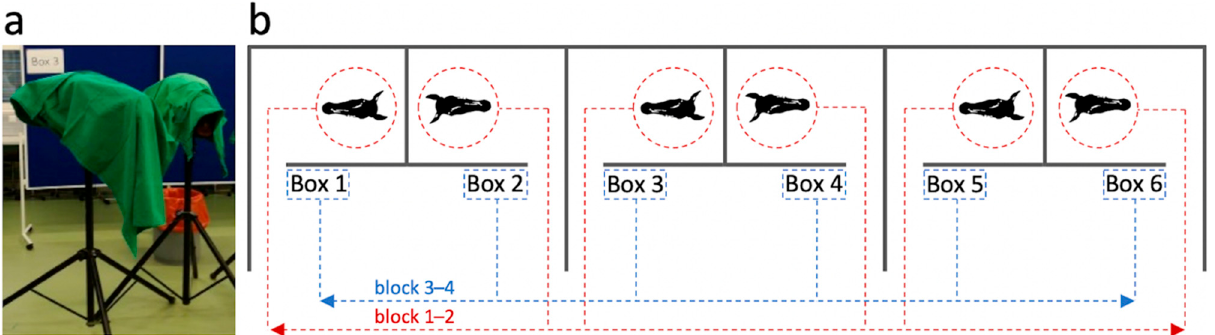
Figure 3. Depiction of the experimental setup. ( a ) Heads fixed on head rests. ( b ) Plan view of exam- ination box setup and head-to-box assignment